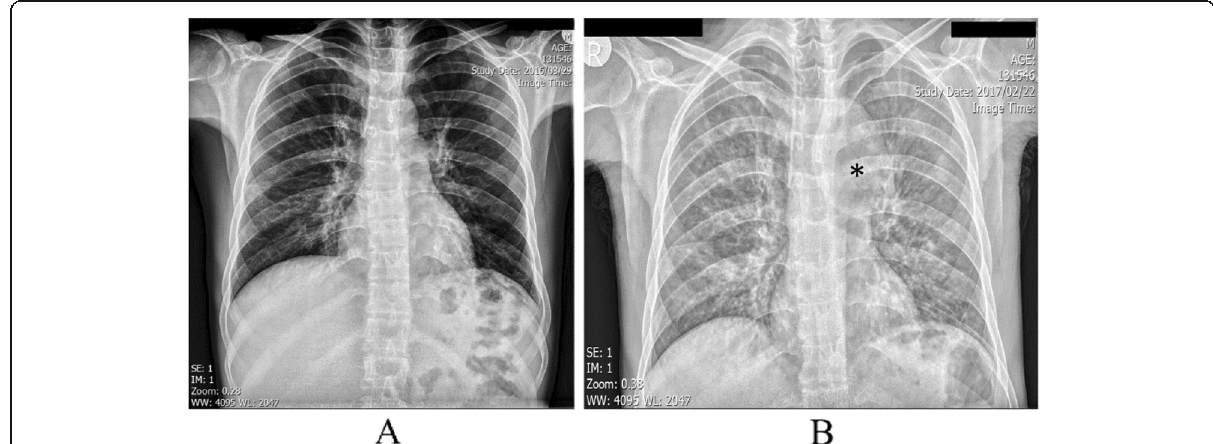
Fig. 1 Two chest X-rays of the patient taken 1 year apart. a The chest X-ray taken when the patient was diagnosed with tuberculosis. b The chest X-ray taken when the patient had exacerbated symptoms after 1 year. A giant mass is seen in the mediastinum, which was not present before. The asterisk marks the described lesion